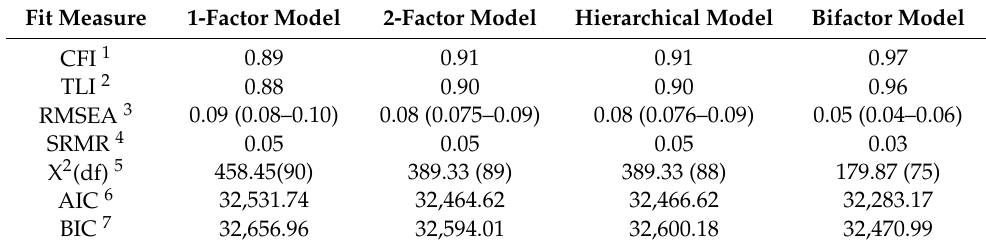
Table 3. Confirmatory factor analysis ( N = 480).